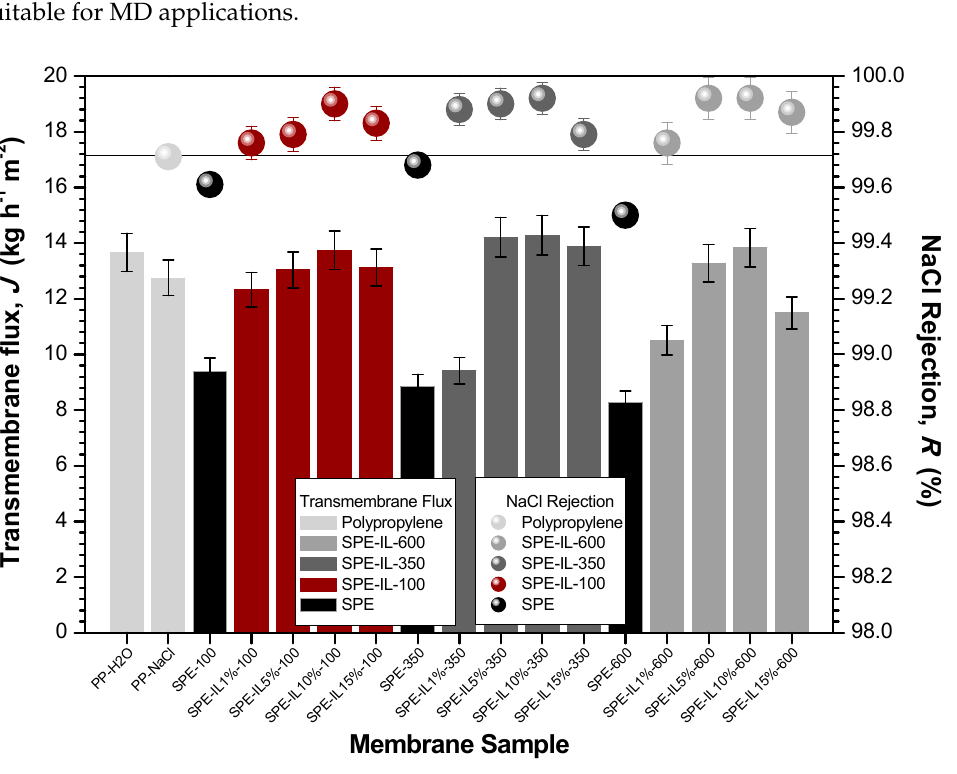
Table 2. Water contact angles for IL-HCMs prepared at 350-µm film solution with different amounts of IL.